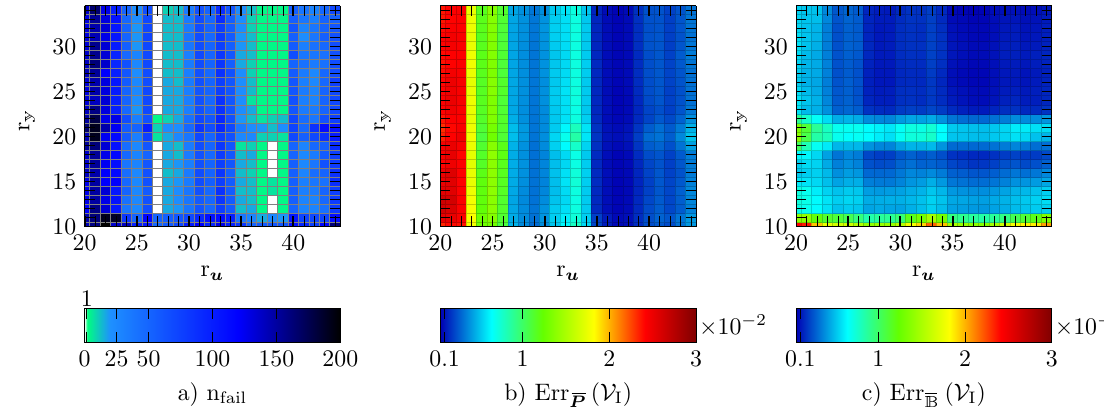
Figure 5. ( a ) robustness and ( b , c ) output error analysis for varying numbers of DEIM indices r u and r y for a reduced basis of size n u = 20 and n y = 10.